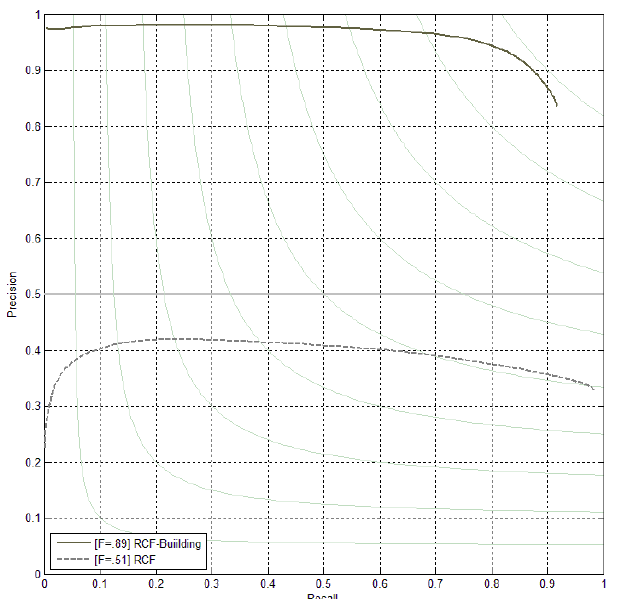
Figure 9. The P-R curves. The solid curve is the result of proposed RCF-building on the test set and the dotted one is the original RCF network.